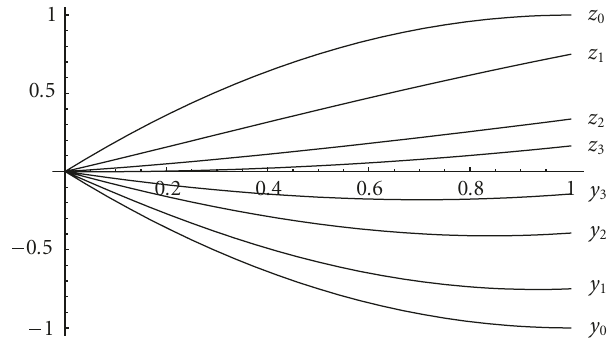
Figure 4.1. Result of three iterations in Example